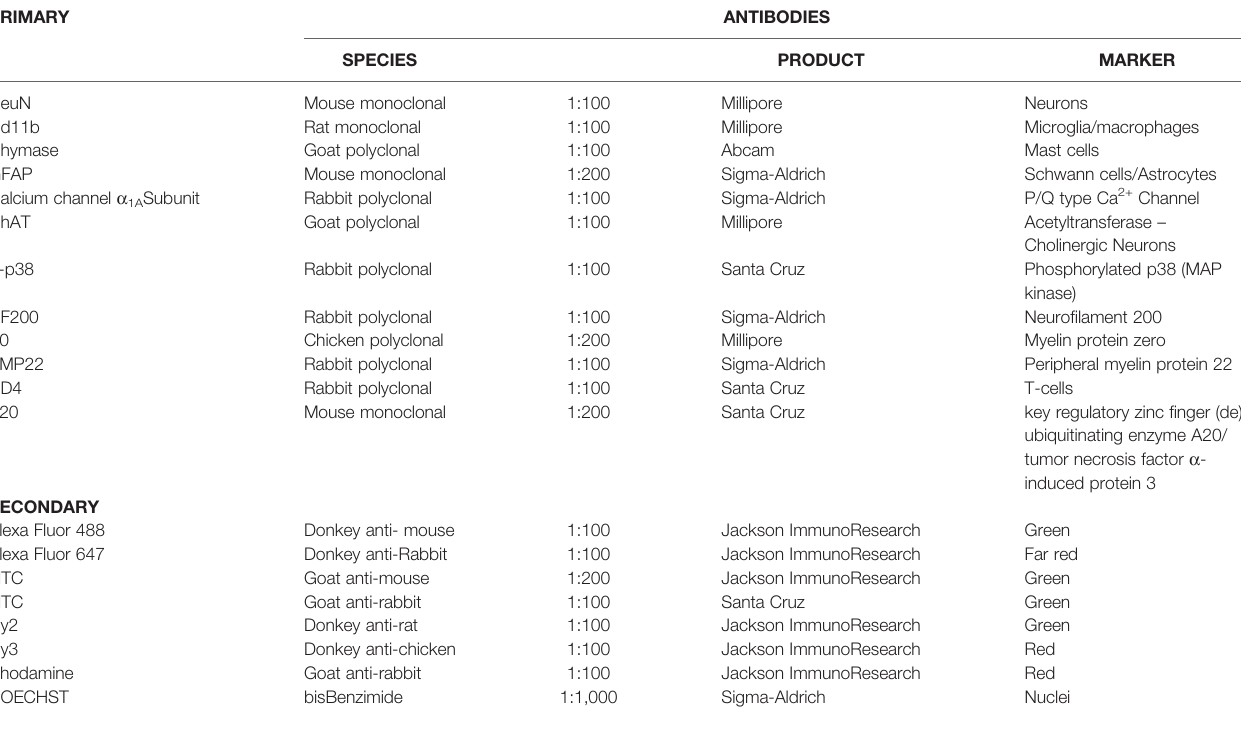
TABLE 1 | List of primary and secondary antibodies.